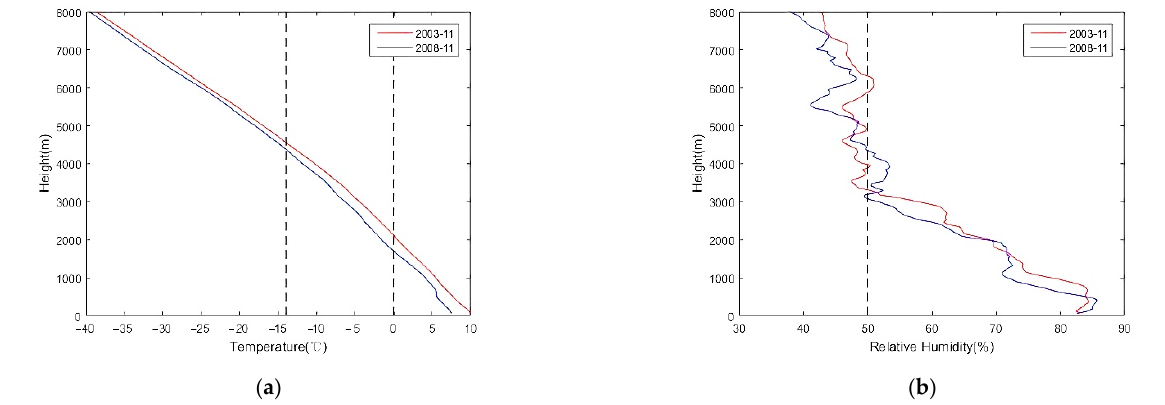
Figure 6. Profiles of average temperature and relative humidity in November 2003 and November 2008. ( a ) Monthly av- erage temperature profile; ( b ) Monthly average RH profile. Considering the definition of Icing Index, vertical dash lines are added to illustrate the range of possible icing.